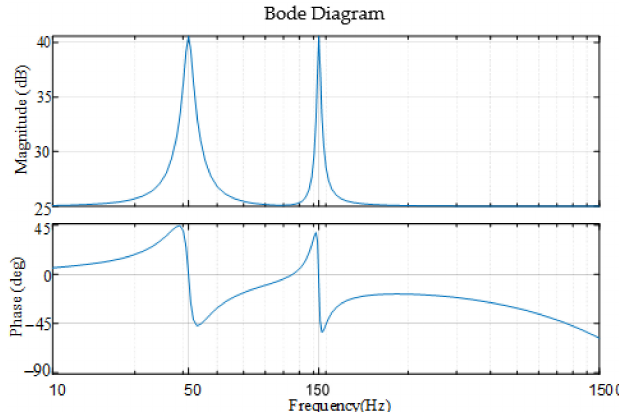
Figure 6. PIDR Bode Diagram when the fundamental frequency is 50